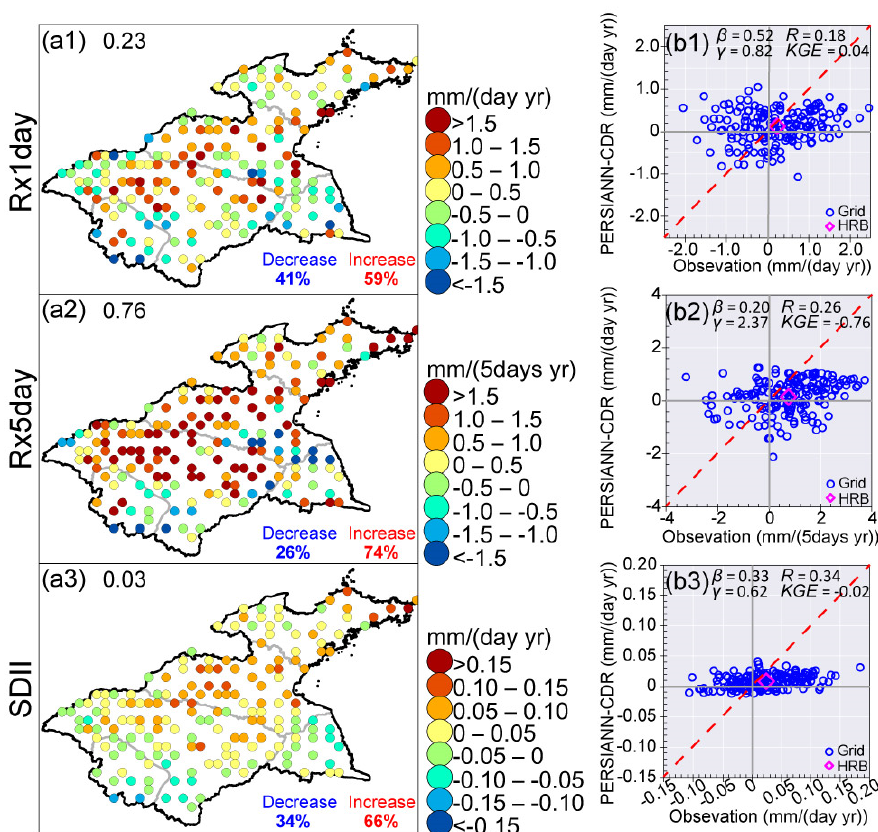
Figure 13. Spatial patterns of the temporal trends of the observational intensity-based indices and the scatterplots between observation and PERSIANN-CDR. a1 – a3 ( b1 – b3 ) are for Rx1day, Rx5day, and SDII, respectively. In a1 – a3 , the black numbers represent the HRB trends of the observational intensity-based indices, while the blue (red) numbers indicate grid percentages with increasing (decreasing) trend across the HRB. The red dashed line in b1 – b3 is the 1:1 line.